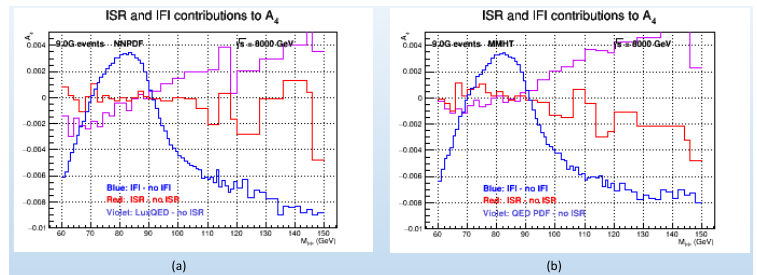
( 8 ) as a function of M A (cid:96)(cid:96) with no lepton cuts: FB 4 3